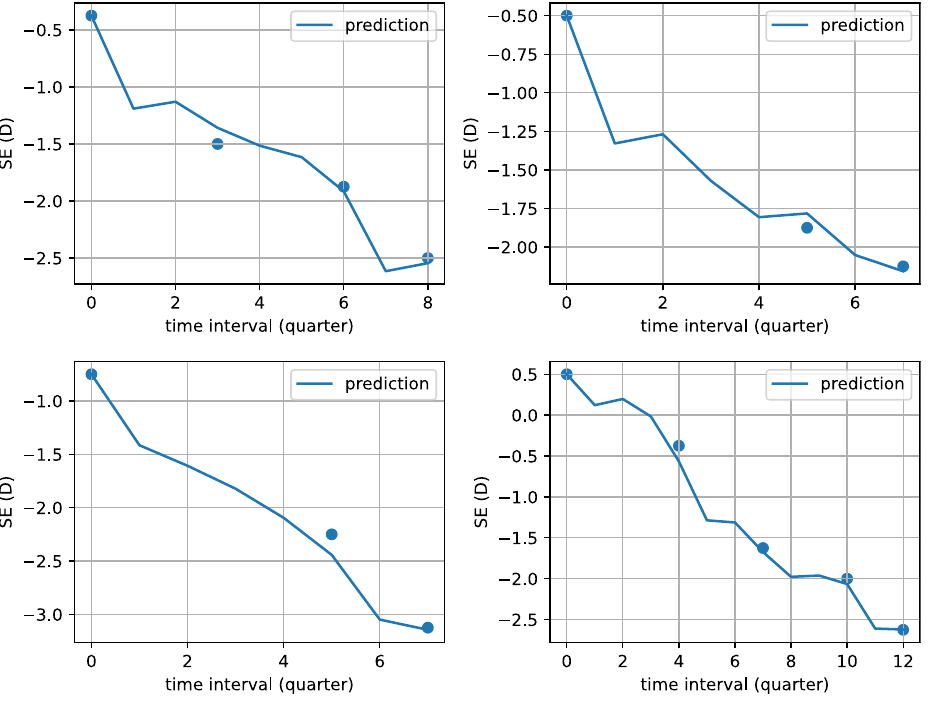
Figure 4. Four case examples of prediction using T-LSTM. In each example, the curve except the starting point means the predicted value, and the data points denote the true values.